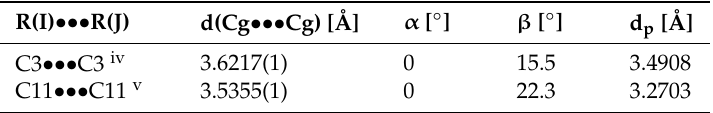
Figure 3. Supramolecular dimers forming a R 22 (22) motif of a unitary graph set. Symmetry codes as in Table 3. Non-classic hydrogen bonds are indicated by dotted lines. Table 4. Interactions in the studied compound. Each ring is indicated by one atom, which belongs solely to this ring. α is a dihedral angle between planes I and J, β is an angle between Cg(I)-Cg(J) vector and normal to plane I and d p is the perpendicular distance of Cg(I) on ring J